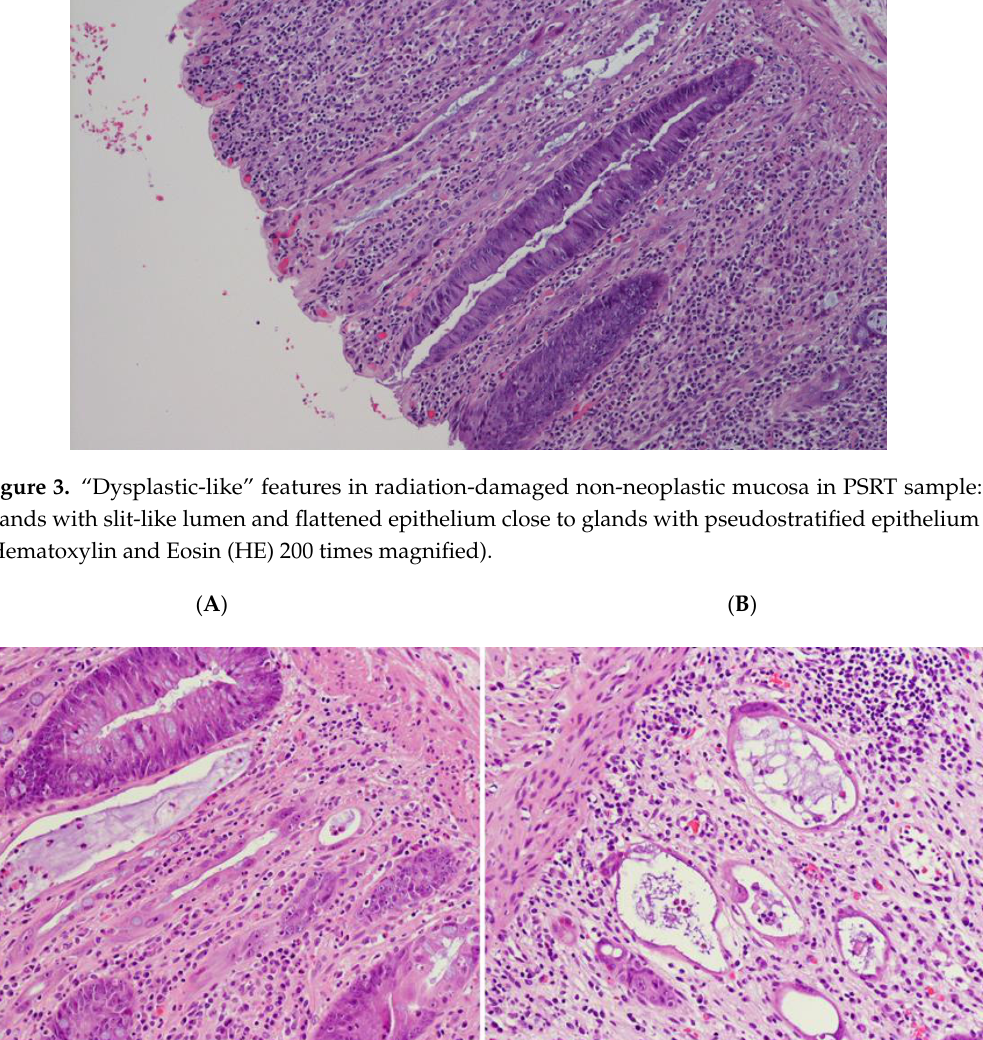
Figure 4. ( A ) “Dysplastic-like” features in radiation-damaged non-neoplastic mucosa in PSRT sample: glands lined by pseudostratified epithelium close to dilated glands with flat epithelium; ( B ) non-neoplastic mucosa in PSRT samples showing dilated glands with flat and atypical epithelial layer (Both A and B are Hematoxylin and Eosin (HE) 200 times magnified).